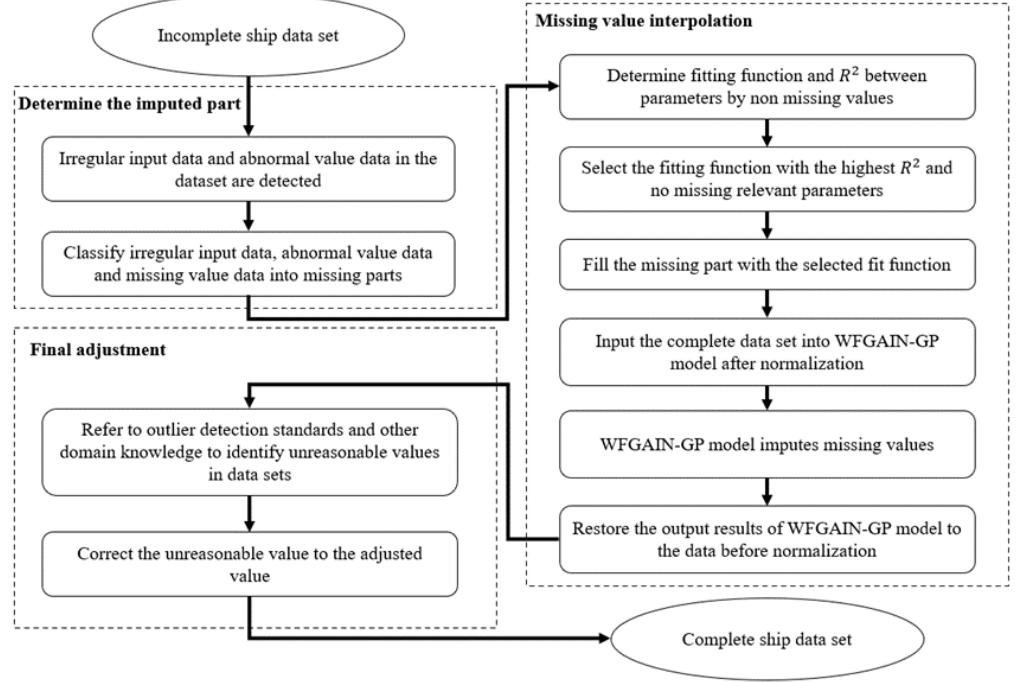
Figure 1. Flowchart for imputing missing values in static ship data. Firstly, identify the part of the data that needs to be imputed, then use the WFGAIN-GP model to impute this part of the data, and finally fine-tune it through experience in the relevant field.